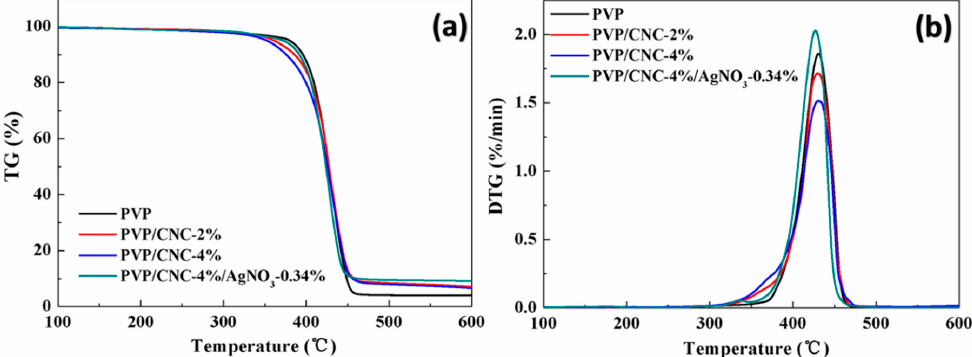
Figure 5. TG ( a ) and DTG ( b ) curves of the electrospun neat PVP, PVP/CNC-2%, PVP/CNC-4%, and PVP/CNC-4%/AgNO 3 -0.34% fibers. PVP/CNC-4%/AgNO 3 -0.34%